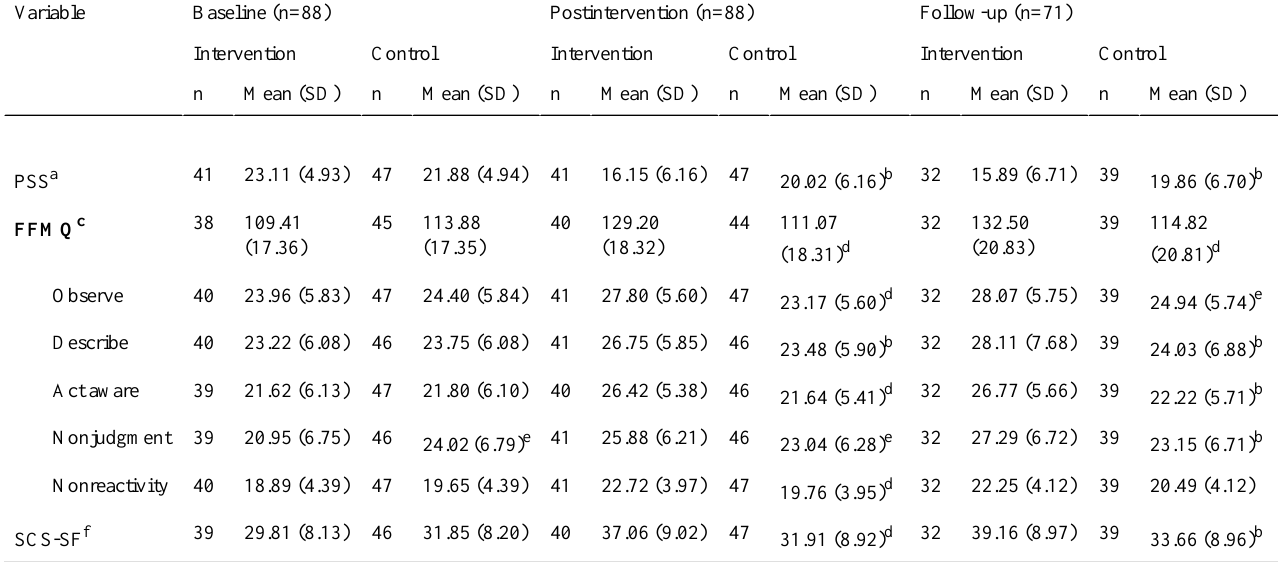
Table 2. Mean scores per study group for perceived stress, mindfulness, and self-compassion.